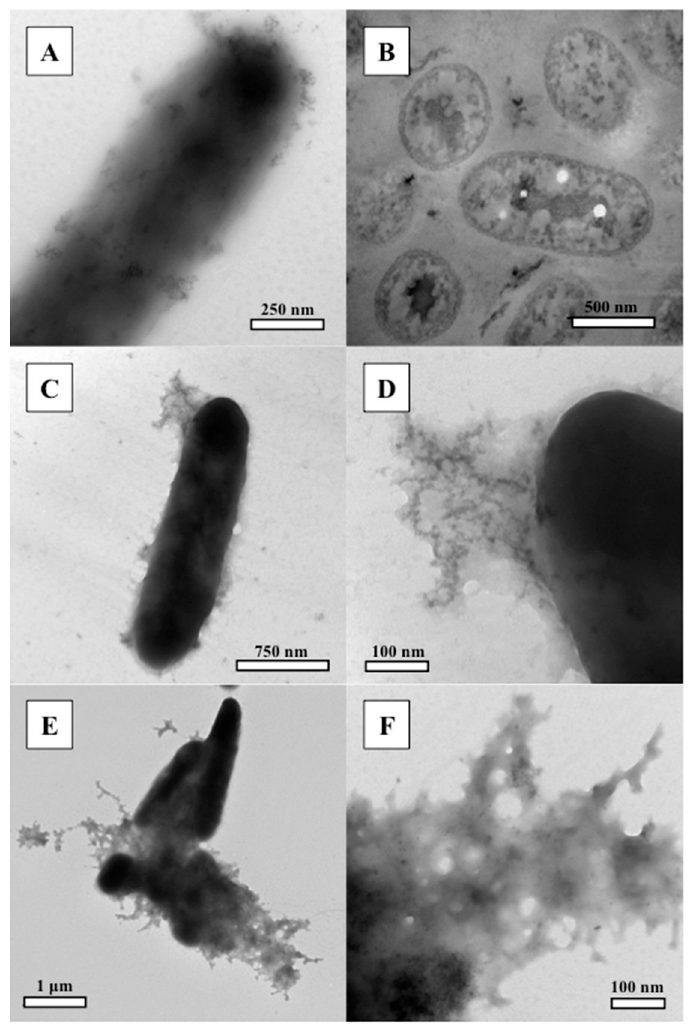
Figure 6. TEM micrographs of C. metallidurans reacted with 5000 µM Pt(IV) for: ( A ) 1 min (whole mount); ( B ) 1 h (ultra-thin section). Pt has been immobilized at the cell envelope and within the cell; ( C , D ) 1 h (whole mount); ( E , F ) 1 day (whole mount). Cells in ( C – F) have lysed and cytoplasmic material possesses colloidal Pt. Staining of cells becomes more pronounced at longer incubation times ( C – F ).